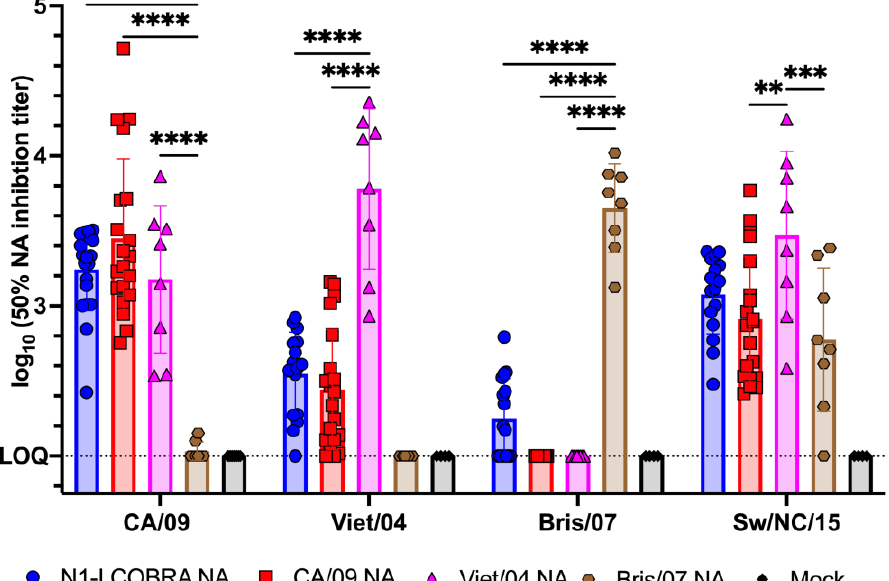
Figure 7. N1-I COBRA NA vaccine elicited NA-inhibiting antibodies to a panel of genetically diverse HXN1 viruses. The 50% NA inhibition (NAI) titers elicited by the NA-based vaccines were measured for a panel of N1 influenza viruses that belong to different N1 genetic clades. Non-linear regression of the ELLA results using RDE treated ferret sera was used to determine the 50% NAI titers (Supplementary Materials). The N1-I COBRA NA vaccination elicited inhibitory antibodies to viruses in the panel. The CA/09 NA and Viet/04 NA elicited cross-reactive NAI antibodies to each other. The Bris/07 NA vaccine elicited NAI antibodies to itself. All NA vaccines elicited antibodies that inhibited the SW/NC/15 virus. The initial serum dilution used for the ELLA assay (1:100) was defined as the limit of quantification at 2.0 log 10 (50% NAI titer). All error bars represent standard